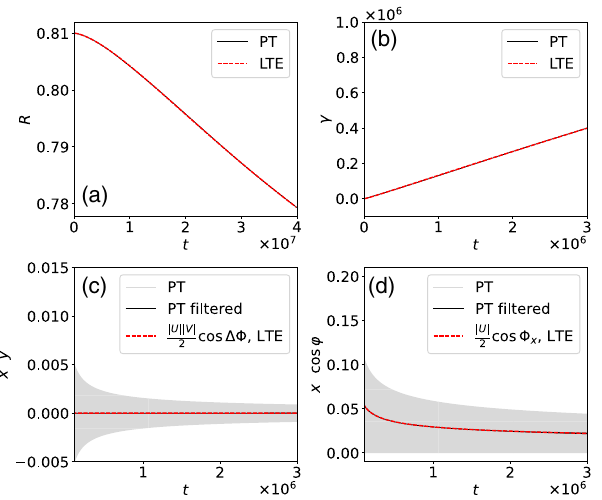
FIG. 3. The numerical comparison of the LTEs and the original equations solved by PTracker in the RR dominant regime. ΔΦ ¼ π = 2 and S > S x y , thus the major axis of the particle trajectory ellipse is on the x axis. (a) R ¼ S y =S x decreases with time due to Eq. (33), thus the ellipse is getting thinner. (b) γ increases due to the acceleration field. (c) and (d) show the same treatments as in Figs. 1(c) and 1(d).